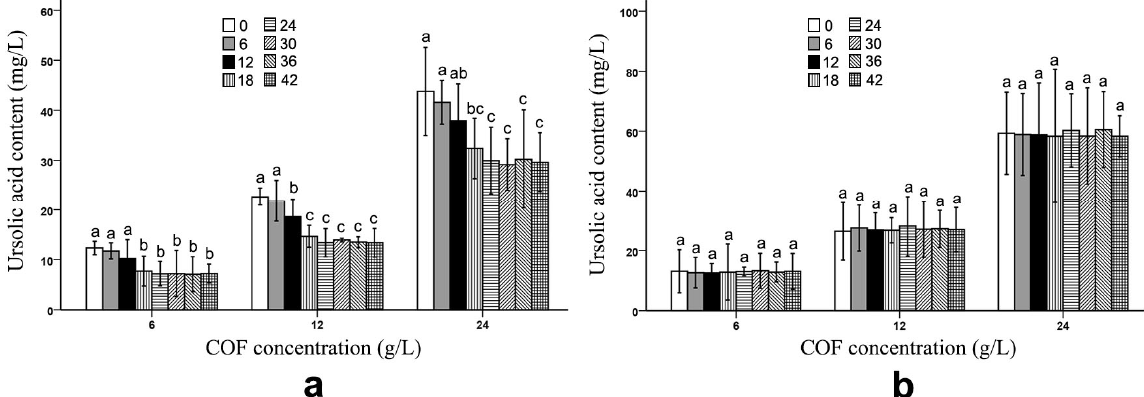
Figure 1. Ursolic acid content in Cornus officinalis fruit (COF) culture broth at different concentrations and fermentation times of Bacillus subtilis and Bifidobacterium bifidum . ( a ) Ursolic acid content in COF culture broth at different concentrations and fermentation duration of B. subtilis . ( b ) Ursolic acid content in COF culture broth at different concentrations and fermentation duration of B. bifidum . Data are the means ± SD from three independent tests. The different letters (a, ab, b, bc, and c) on the error bars indicate significant differences at p < 0.05 between the ursolic acid contents of different fermentation durations on the same COF concentration and strain. The significant differences ( p < 0.05) of the mean values were detected by T-test.